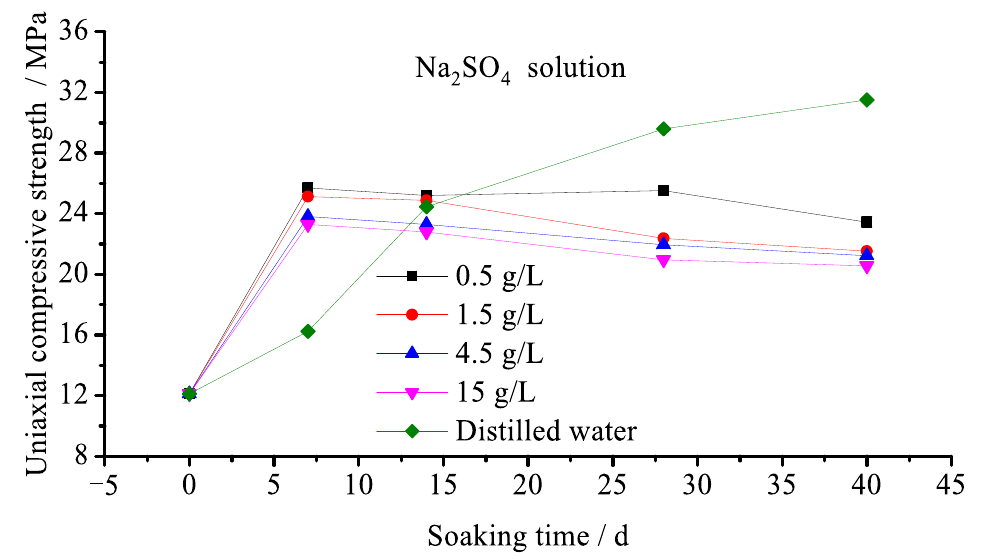
Figure 3. Uniaxial compressive strength of paste backfill specimens submerged in various sulfate solutions according to age.